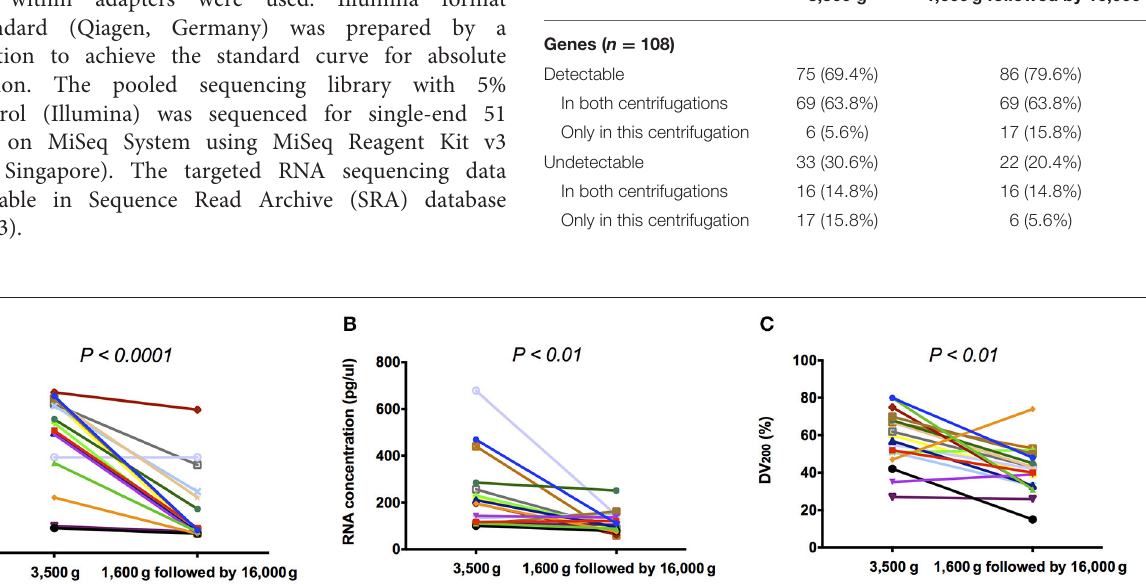
FIGURE 1 | The quality and quantity of plasma RNA. (A) RIN; (B) RNA concentration; and (C) DV 200 of extracted plasma total RNA in 3,500g were significantly higher than those in 1,600g followed by 16,000g ( P < 0.05, Wilcoxon matched-pairs signed rank test).